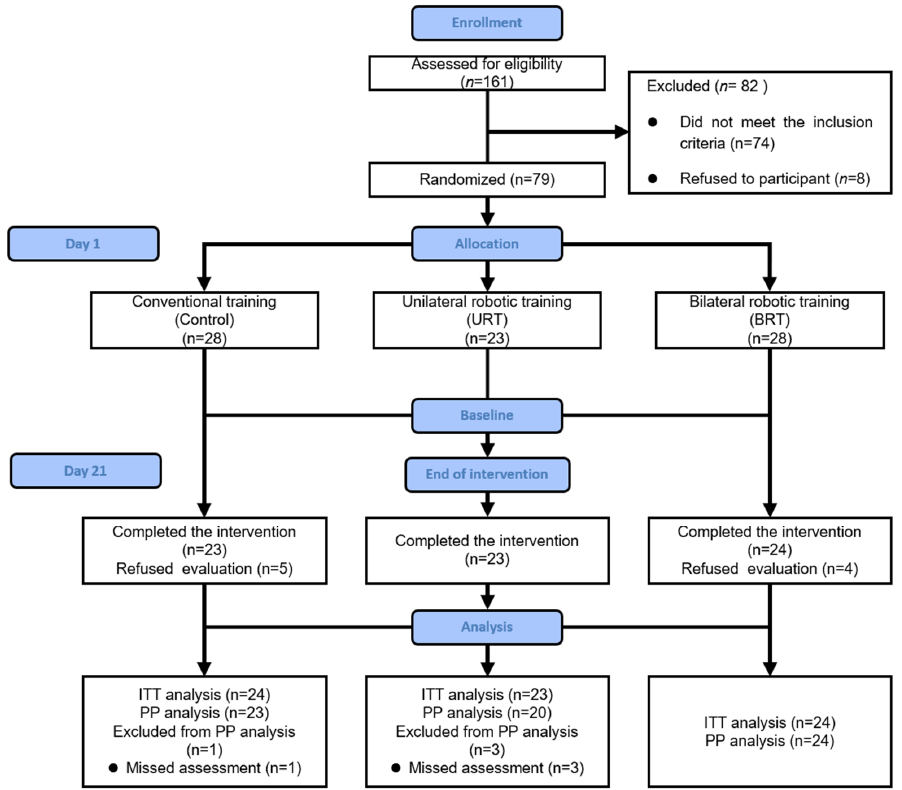
Figure 1. Consolidated Standards of Reporting Trials (CONSORT) fl ow diagram.